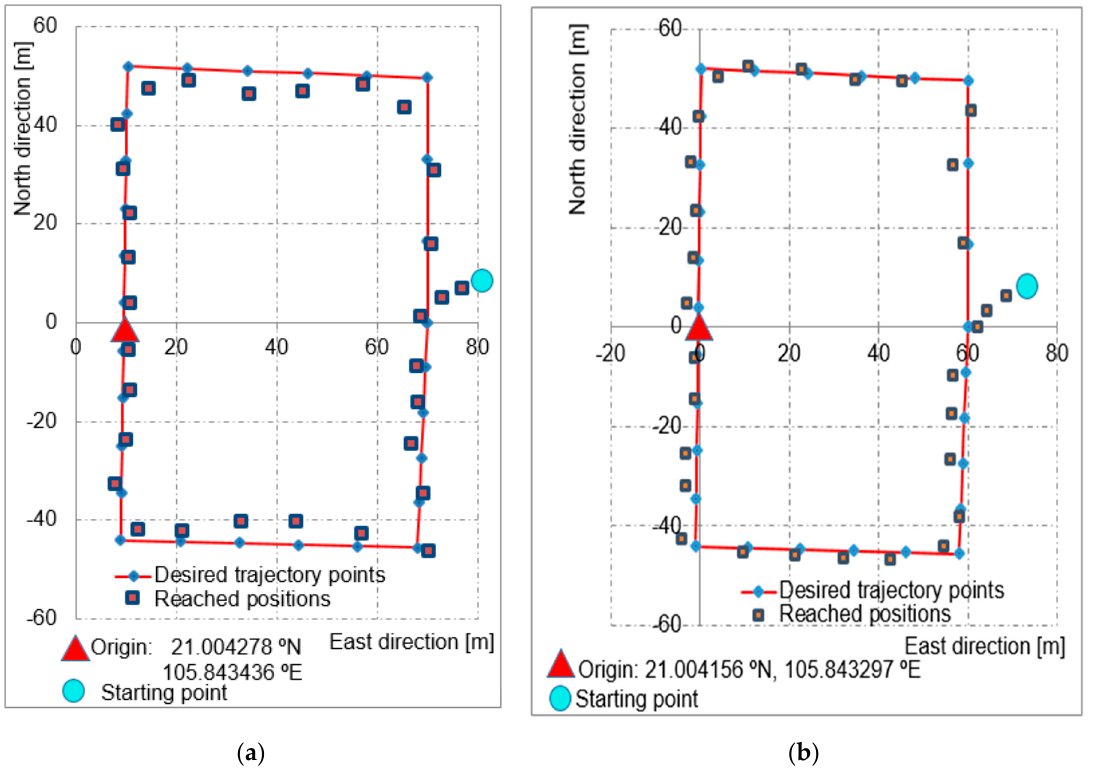
Figure 10. The AUV reached and followed a desired rectangle-shaped trajectory: ( a ) with the extended Kalman filter (EKF) algorithm; ( b ) with the unscented Kalman filter (UKF) algorithm.